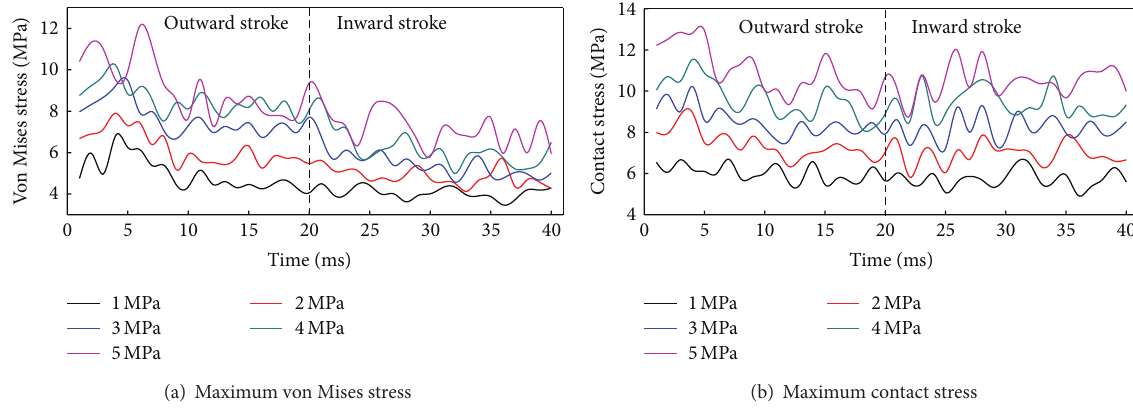
Figure 17: Stress of the biomimetic sealing ring under different medium pressures.